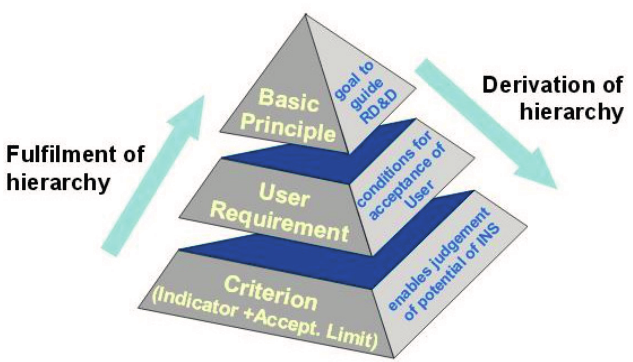
Figure 1. INPRO hierarchy of